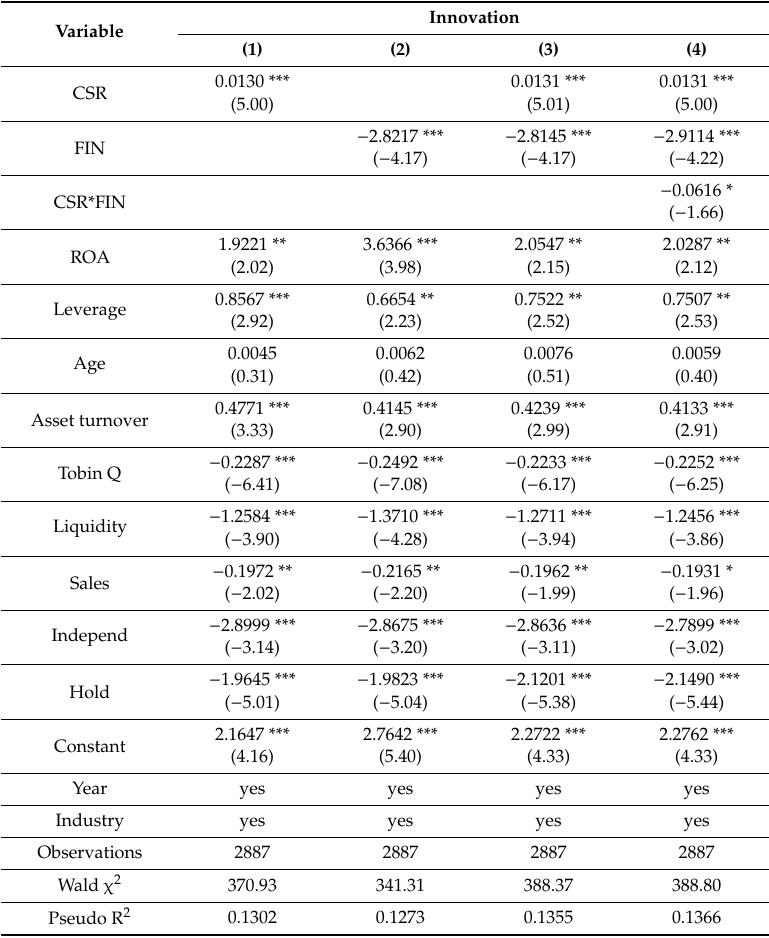
Table 12. Regression results of robustness